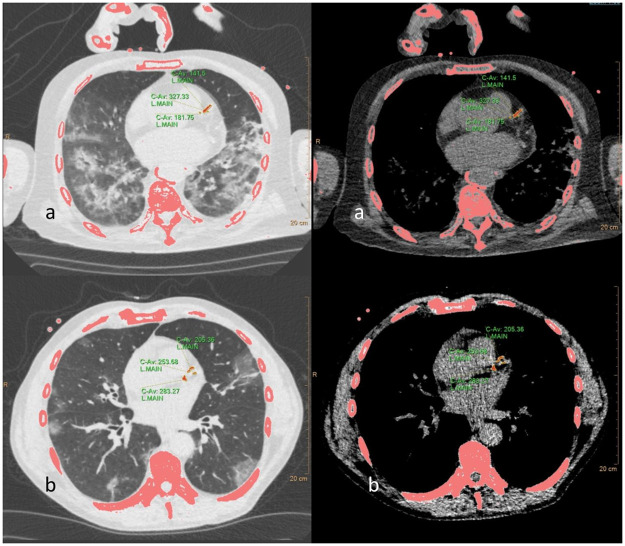
Quantification of calcified plaque burden in the LAD in the native COVID-19 screening CT in two representative patients a) 70 yrs, male b) 53 yrs, male.Both patients had a prolonged period >14 days on intensive care unit.